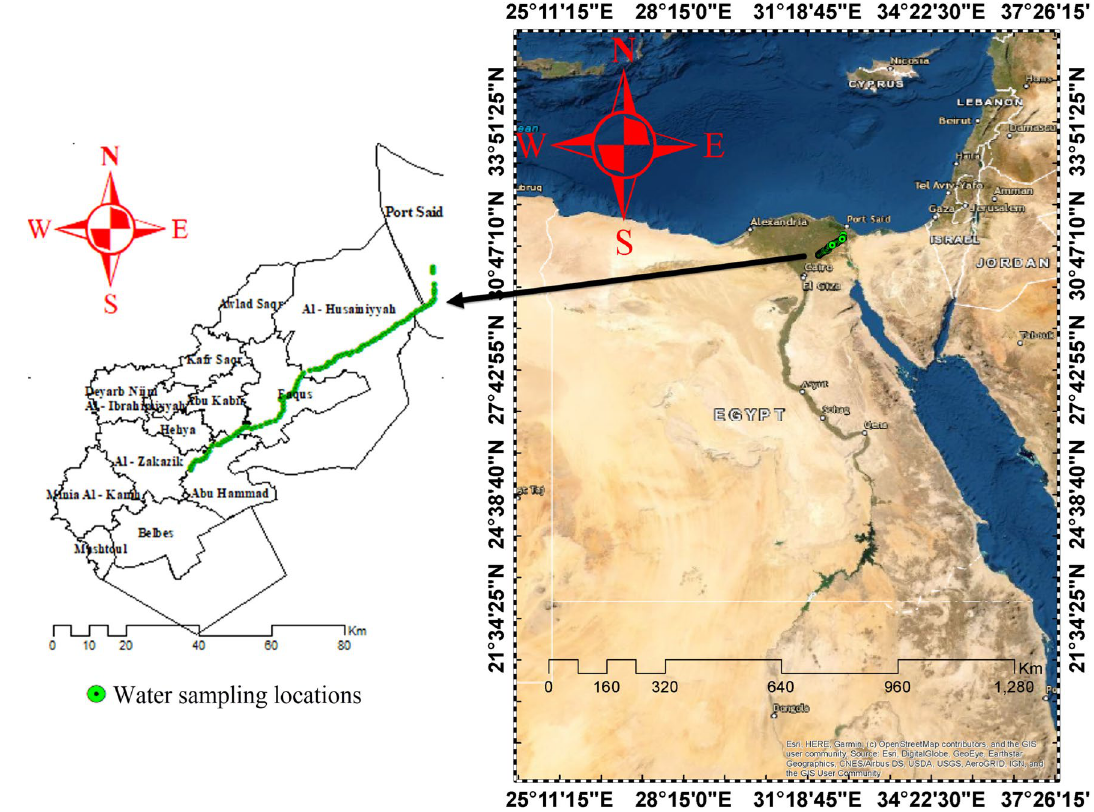
Fig. 1 Location of the Bahr El-Baqr drain and sampling locations in green along the